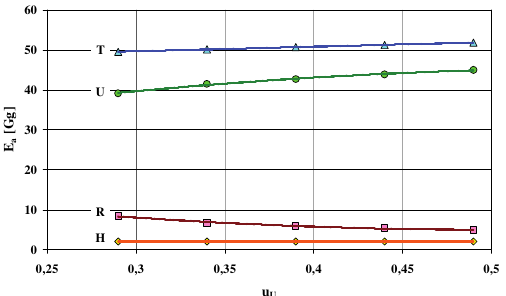
Fig. 6. Dependence of the national annual emission of particulate matter from the exhaust system of passenger cars engines upon the road length travelled under the following model traffic conditions: U – urban, R – rural, H – on highways and expressways and T – under all